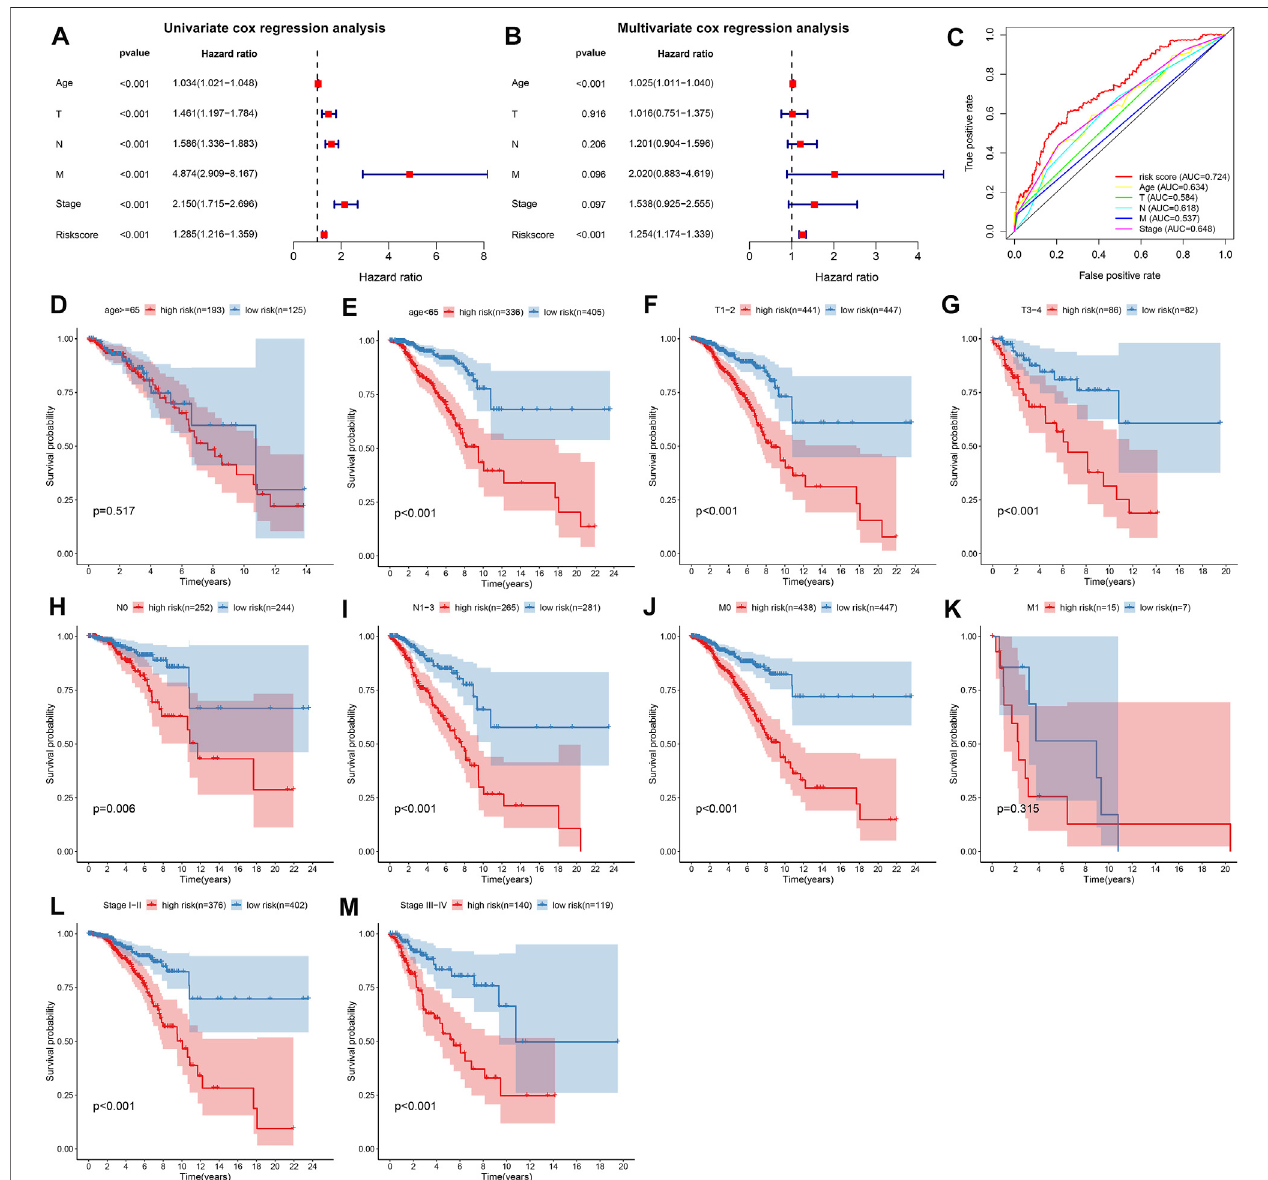
FIGURE 2 | The TSG-based prognostic classi fi er is independent of conventional clinicopathological parameters across breast cancer in TCGA dataset. (A,B) Uni- andmultivariateCoxregressionmodelsoftheassociationsbetweenage,T,N,M,stage,andRSandOSofbreastcancerpatients. (C) Comparisonoftheareaunderthe curve (AUCs) of age, T, N, M, stage, and RS. Kaplan – Meier curves and log-rank tests of high- and low-risk breast cancer patients at different subgroups according to clinicopathological parameters, including (D,E) age ≥ 65 and < 65; (F,G) T1-2 and T3-4; (H,I) N0 and N1-3; (J,K) M0 and M1; (L,M) stages I – II and stages III –